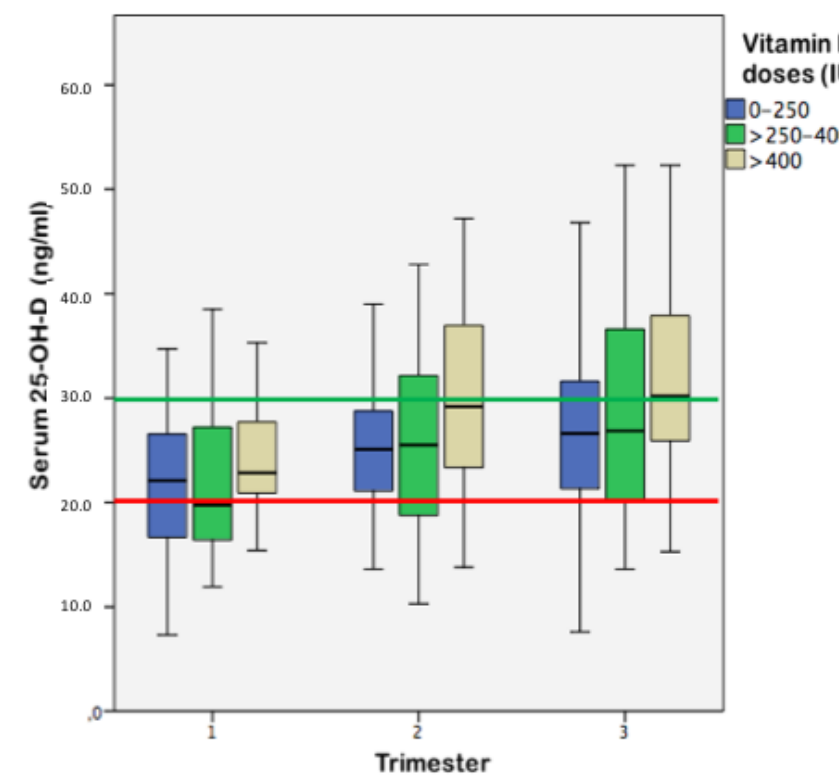
Figure 2. Serum vitamin D concentrations (25-OH-D) during pregnancy according to vitamin D3 supplementation. The green line represents the cut-off point for adequate vitamin D status (25-OH-D ≥ 30 ng/mL). The red line represents the cut-off point for vitamin D deficiency (25-OH-D < 20 ng/mL).